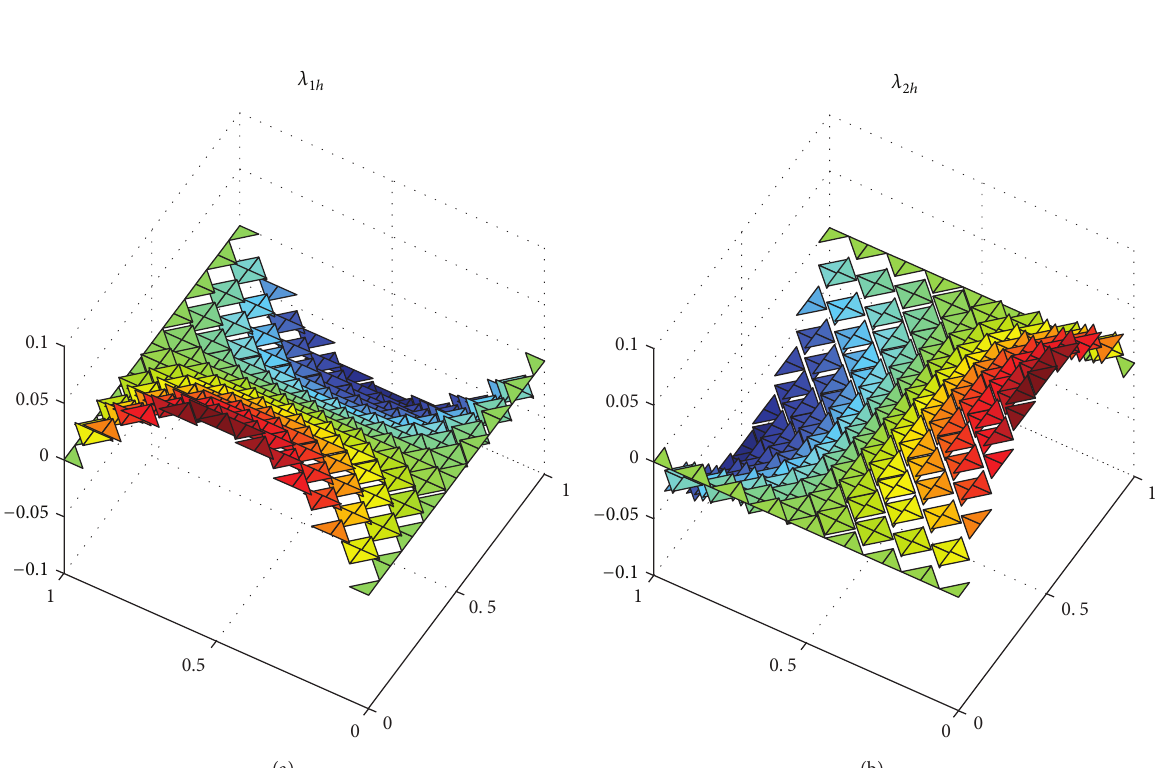
Figure 3: Surface for exact solution 𝜆 = (𝜆 1 , 𝜆 2 ) .